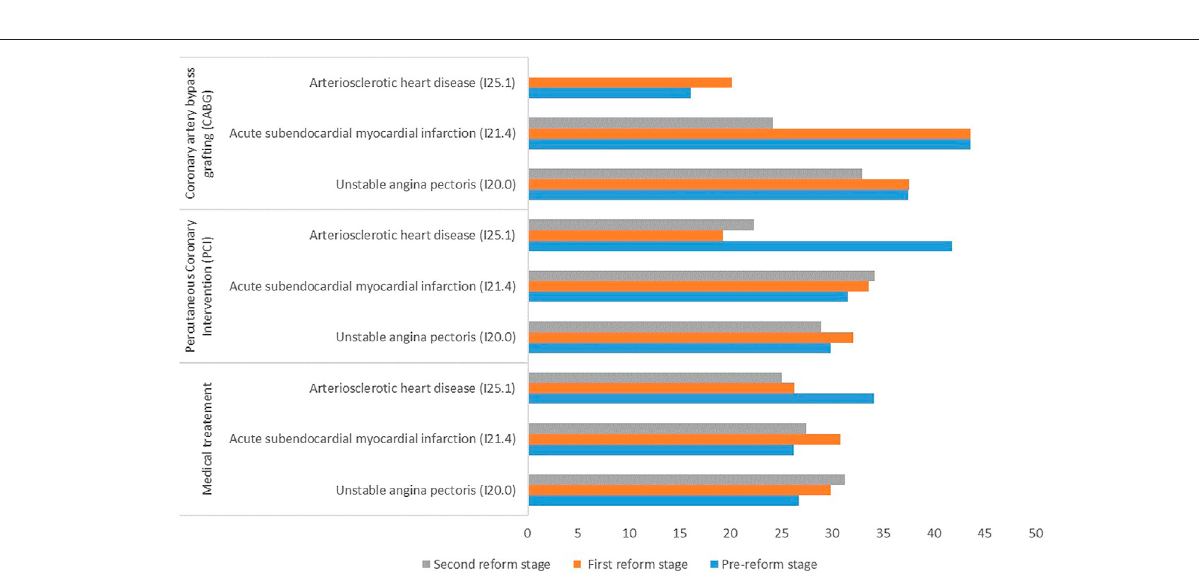
Frontiers in Pharmacology |